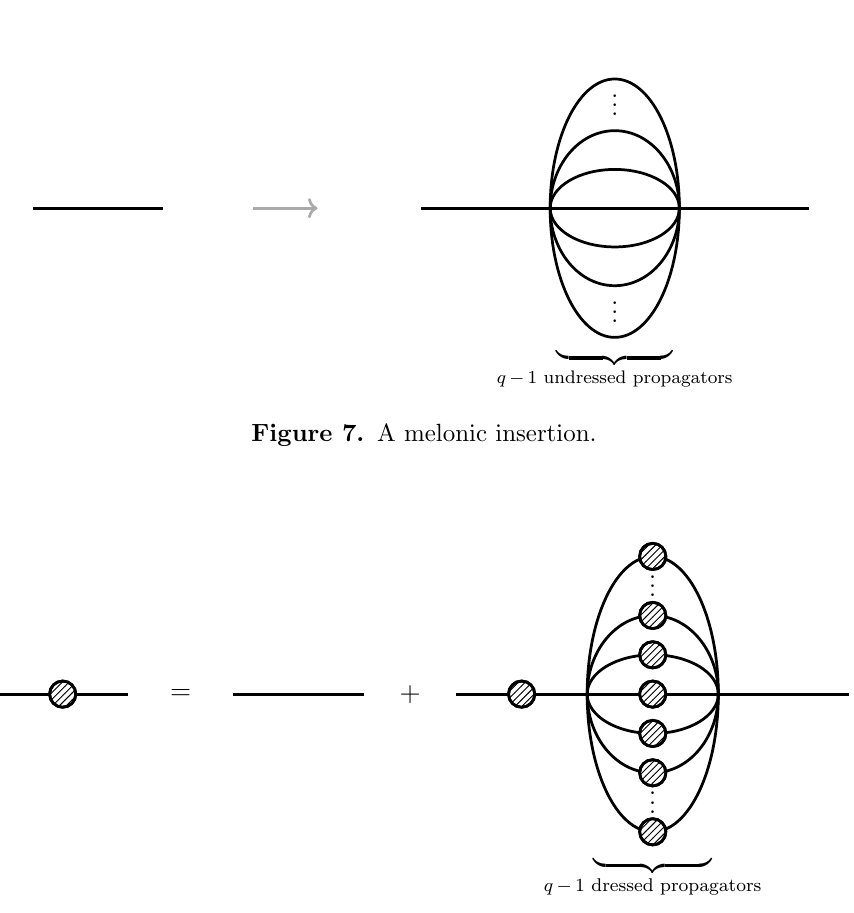
Figure 8. The Schwinger-Dyson equation for the dressed